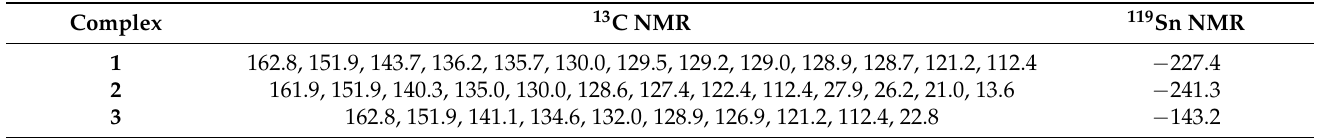
Table 4. 13 C and 119 Sn NMR spectral data of 1 – 3